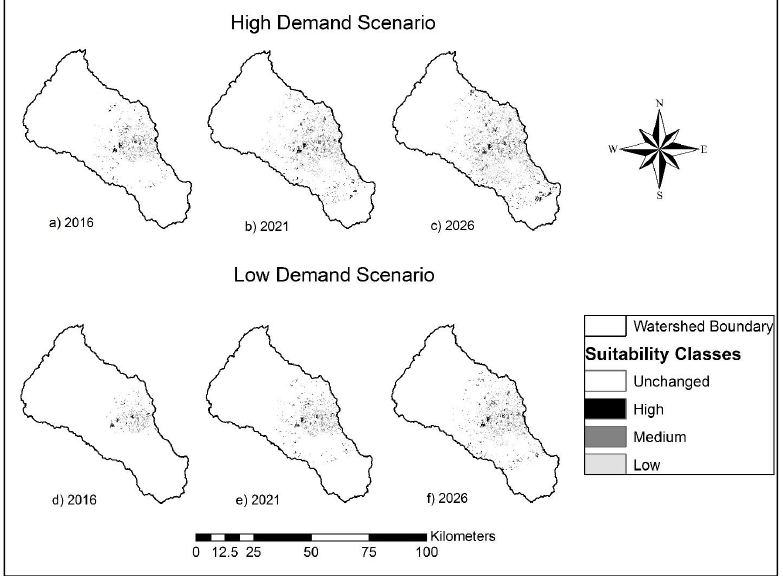
Figure 6. Allocation of suitable sites for pine plantation under high and low demand scenarios.